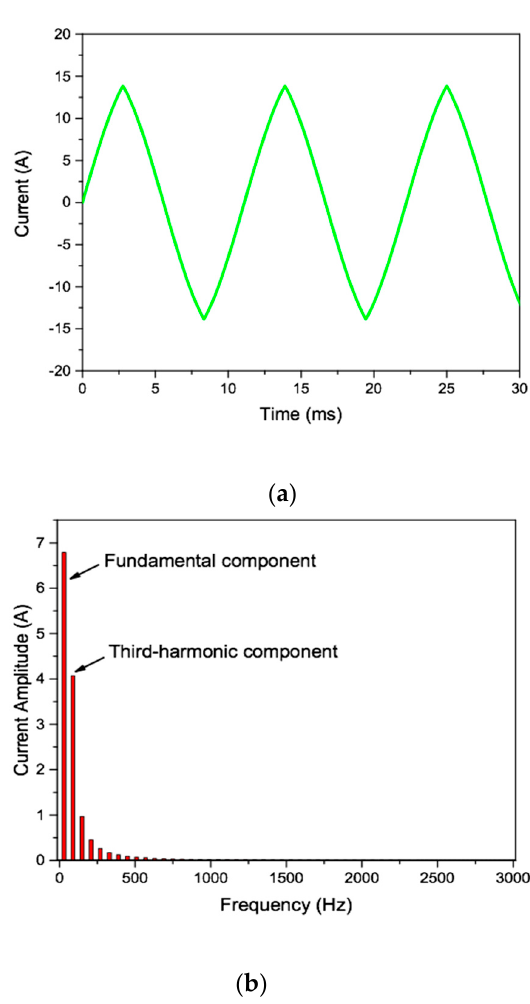
Figure 6. ( a ) Sum of three-phase currents, and ( b ) the fast Fourier transform (FFT) plot of phase A current.